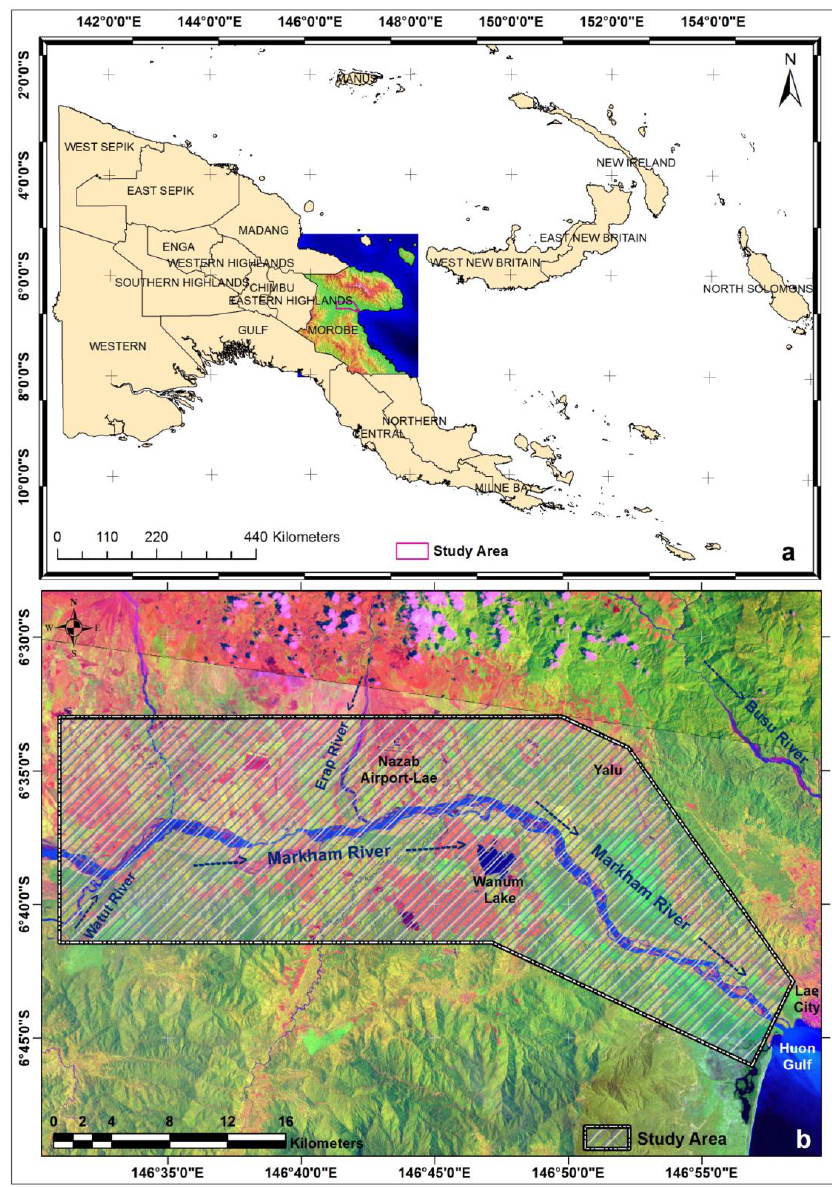
Figure 1. Location map of the study area.